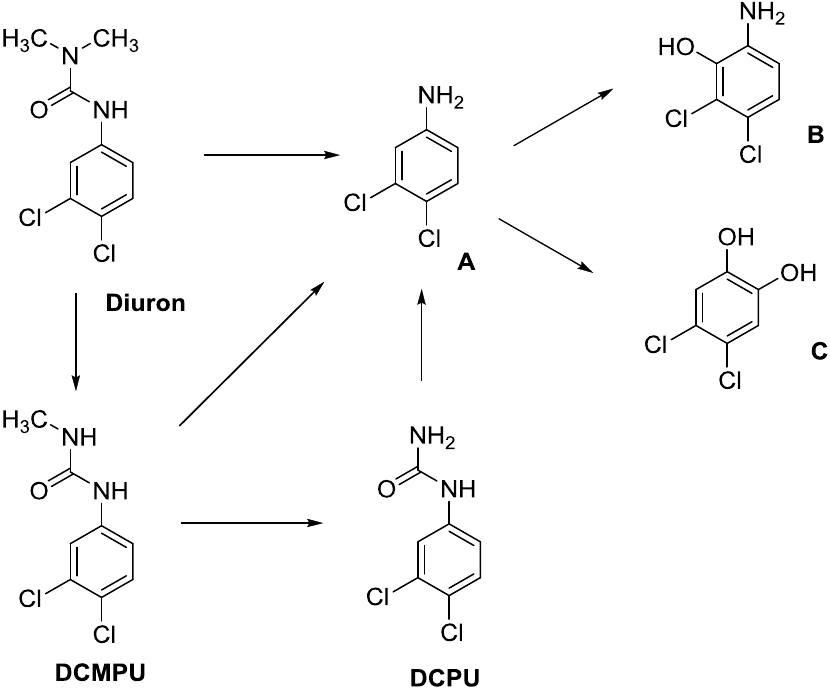
Figure 1. Some of the predicted metabolites from the biodegradation of Diuron.